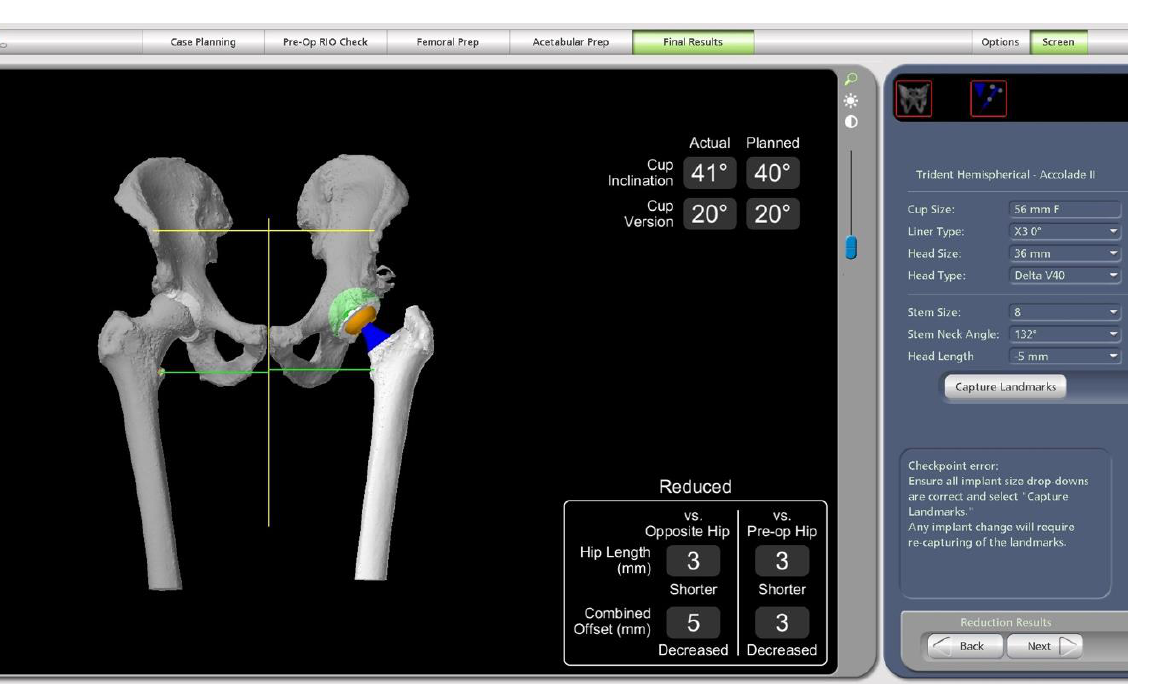
Figure 5. Intraoperative screenshot showing the actual cup position compared to the pre-operative plan. Leg length and combined offset changes are also displayed.